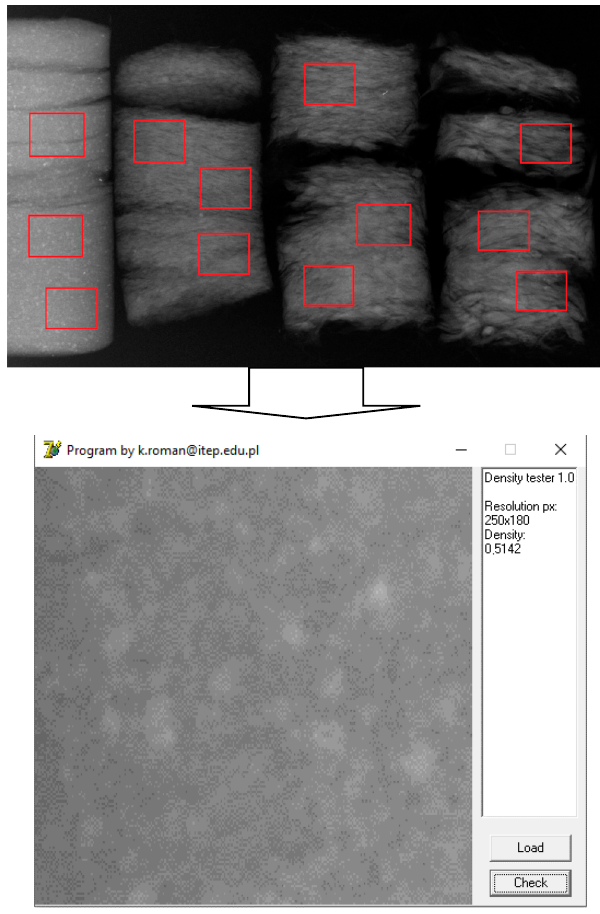
Figure 4. Schematic of screen